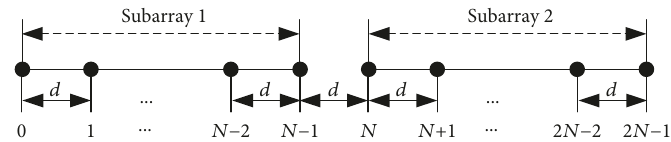
Figure 1: Subarray selection from a ULA with M = 2 N